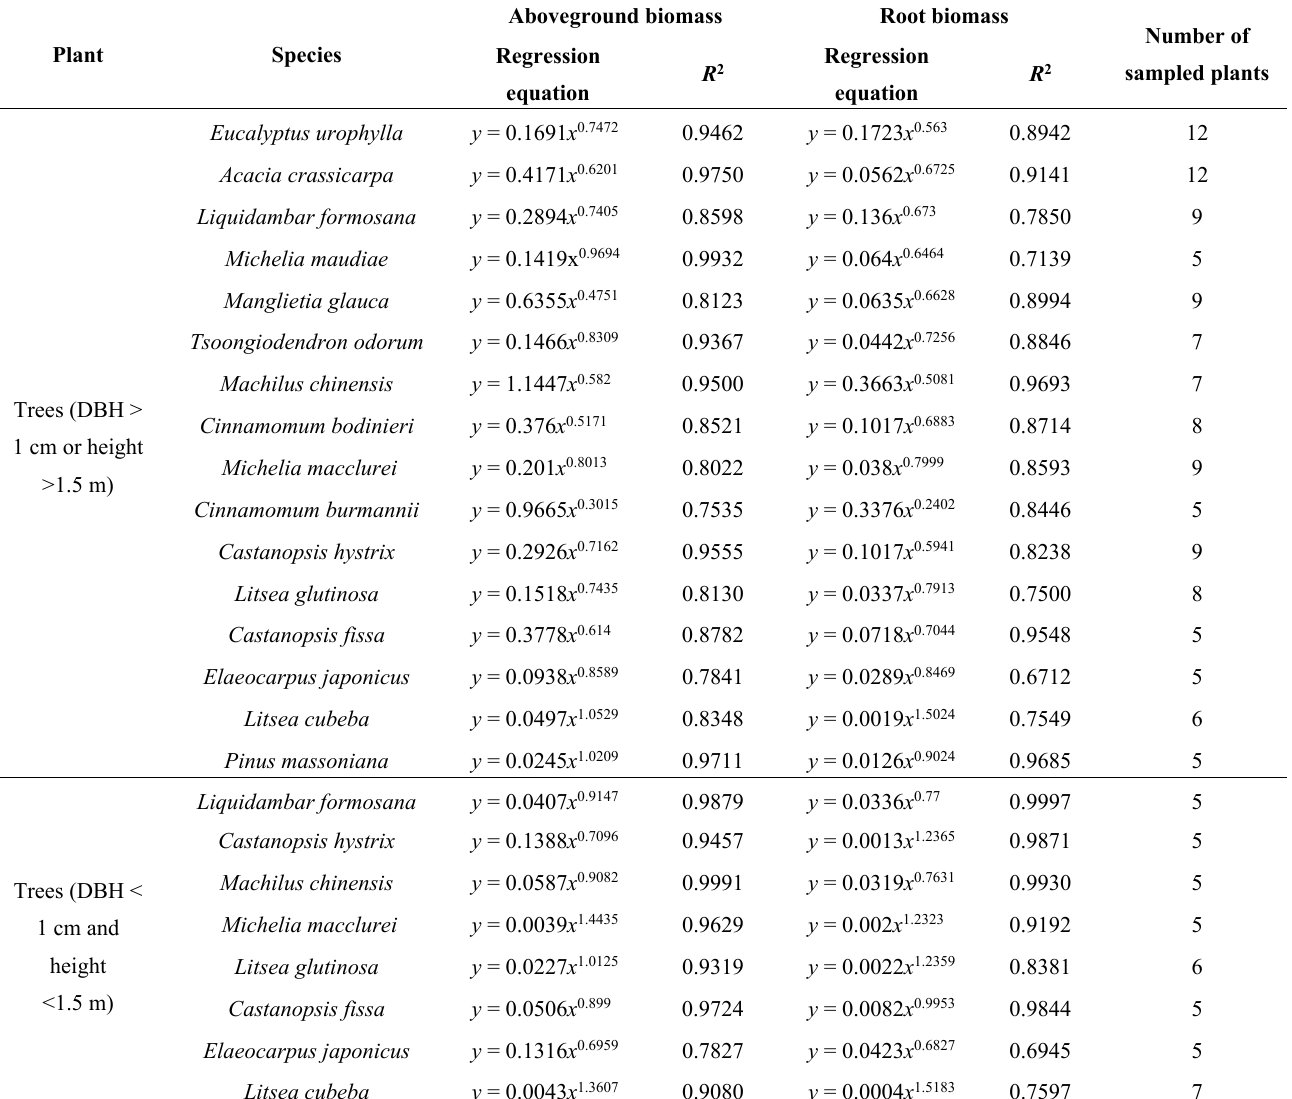
Table 1. Allometric regression equations and the